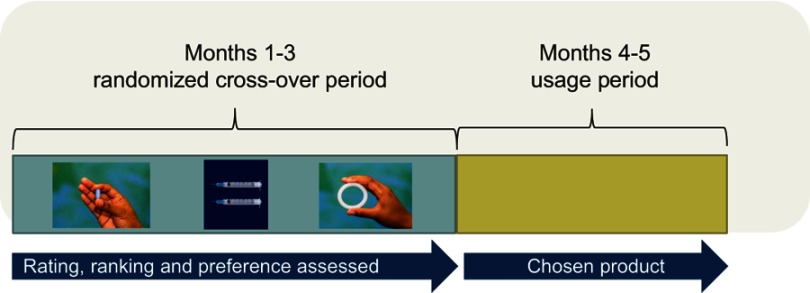
TRIO study design.Abbreviation: TRIO, Tablets, Ring, Injections as Options.